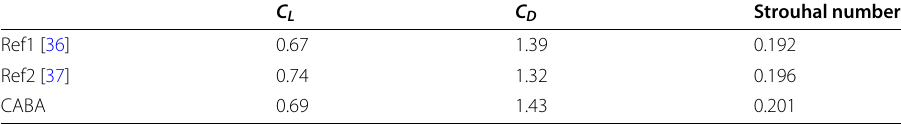
Table 1 Comparison of the present results against reference for flow over a cylinder C L C D Strouhal number